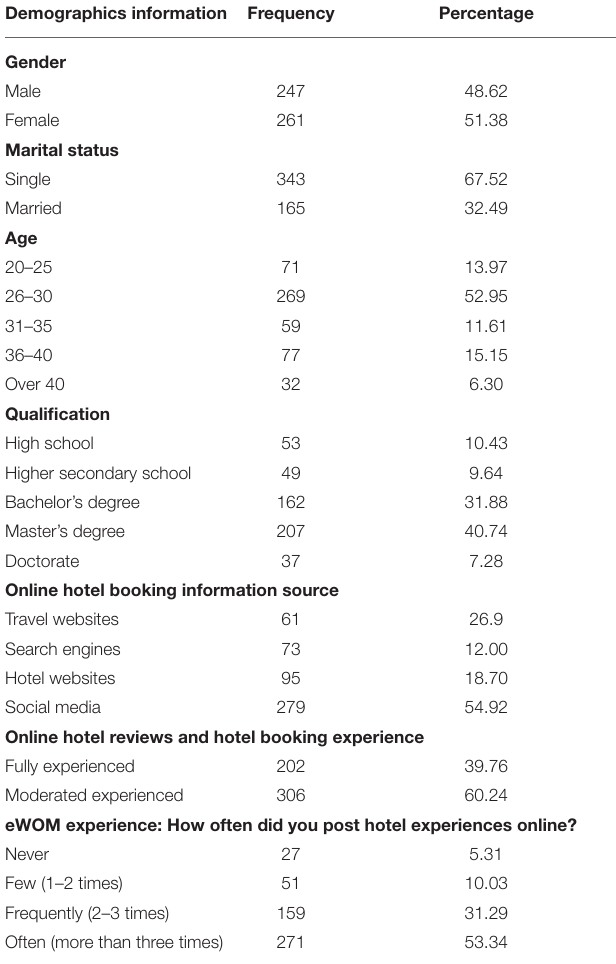
TABLE 1 | Respondents’ profile ( n =